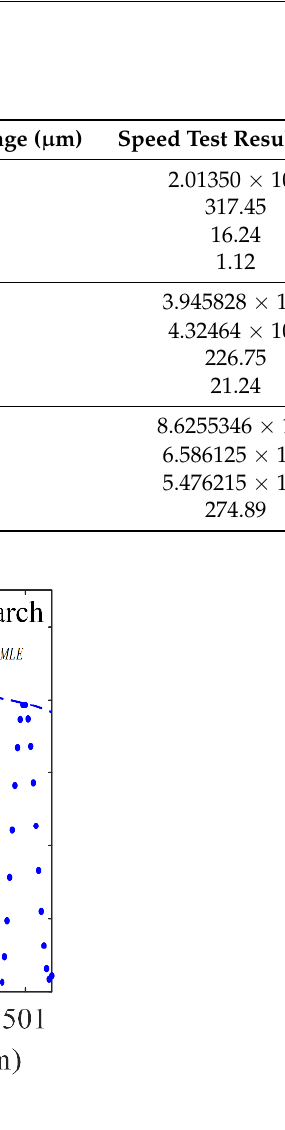
Figure 4. The implementation steps of the MLE algorithm: ( a ) FFT rough estimate and ( b ) MLE fine estimate (Assuming L = 500 μ m).